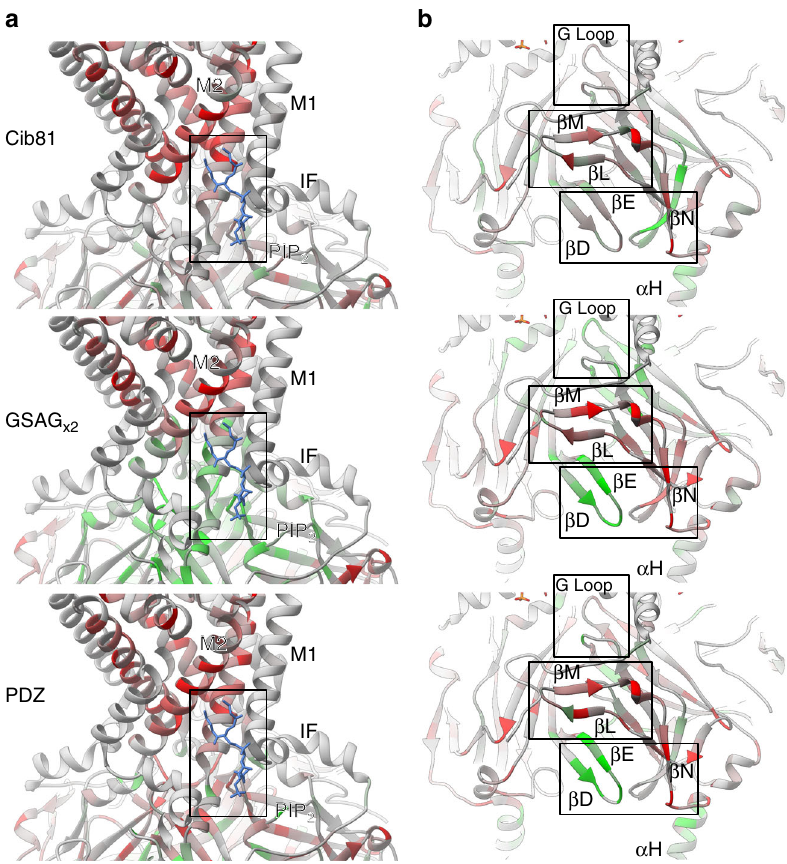
Fig. 3 Differential domain insertion permissibility. Permissibility data is mapped on the crystal structure of chicken Kir2.2 (PDB 3SPI). Domain insertion permissibility for three different domains (indicated on the left) is shown colored increasing from red to green. a All types of insertions into transmembrane helixes (e.g., M2) are strongly selected against. Permissibility in PIP 2 binding site (boxed) depends on structural context of the insertion. b Some non- conserved, surface-exposed loops (e.g., β N) were not permissive, while the β D – β E loop (which binds G βγ in GIRK) and the G-loop ( β H – β I, the cytoplasmic gate in Kir2.1) have context-dependent permissibility (i.e., permissive for GSAG x2 and PDZ insertion, less permissive for Cib81